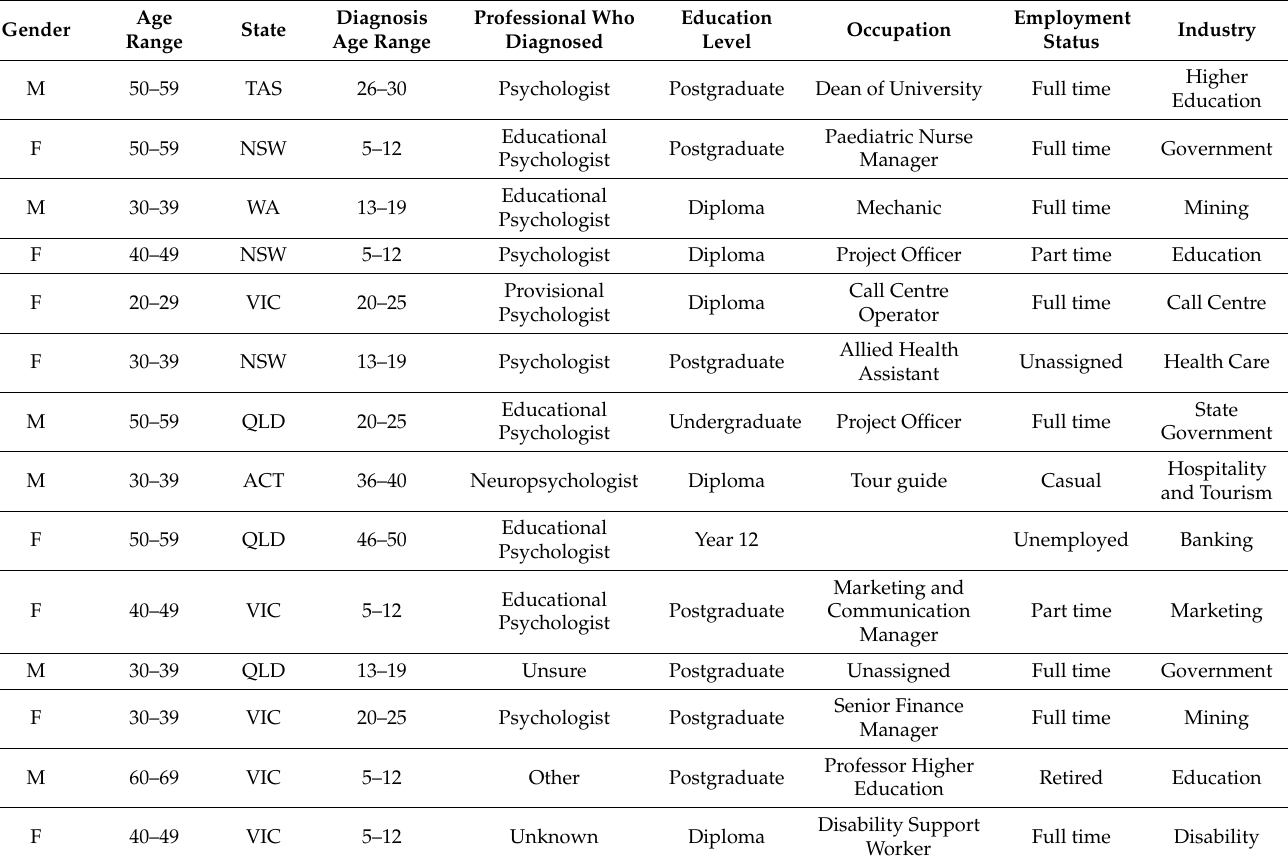
Table 1. Participant